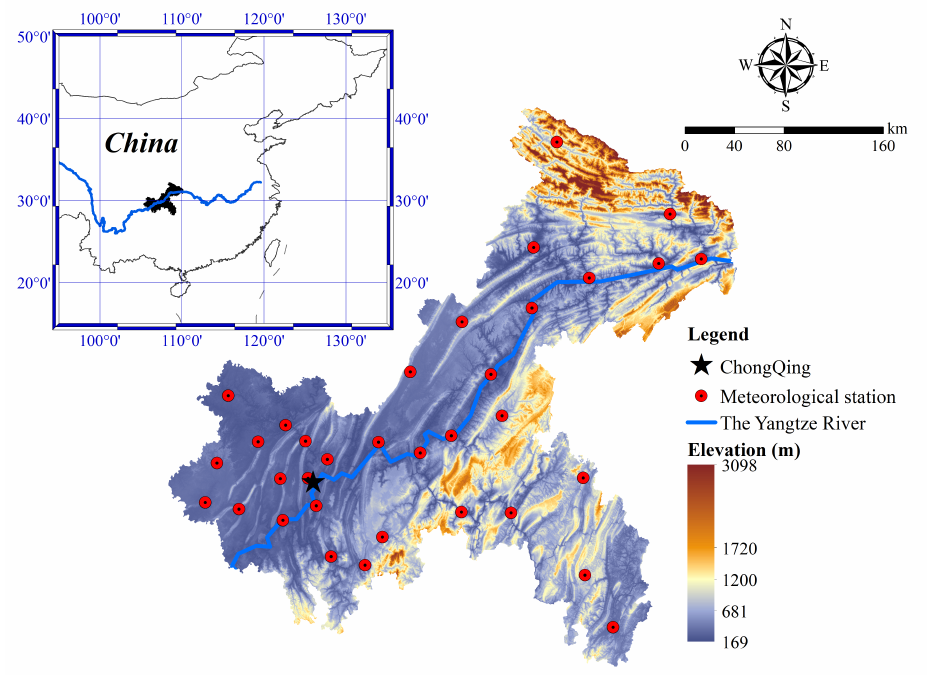
Figure 1. Geographical location and distribution of meteorological stations in